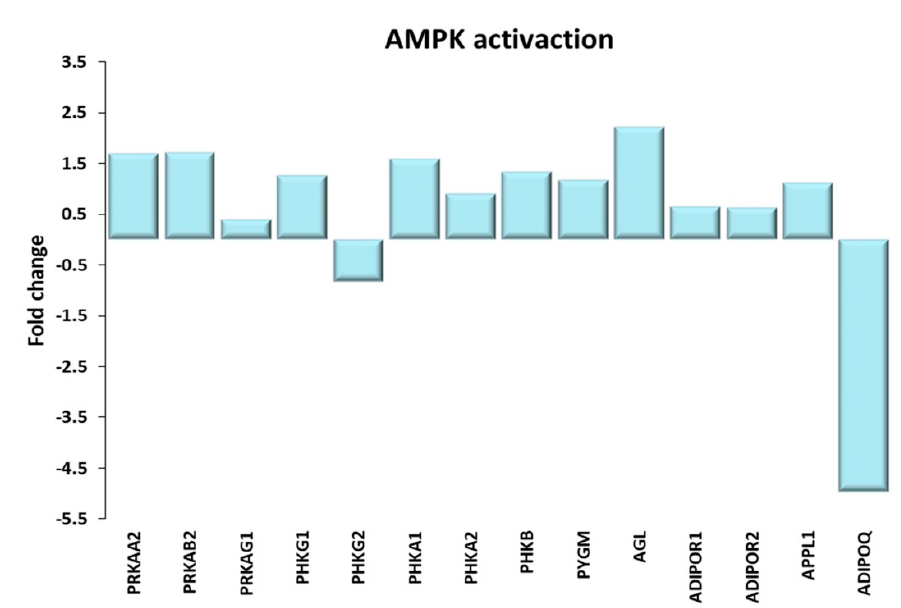
Figure 5. AMPK activation. Genes discussed in the text are shown here as fold change in the comparison of TRA and SED subjects. PRKAA2: Protein kinase AMP-activated catalytic subunit α 2; PRKAB2, PRKAG1: Protein kinase AMP-activated non-catalytic subunit β 2, γ 1; PHKG1, PHKG2: phosphorylase kinase catalytic subunit γ 1, 2; PHKA1, PHKA2, PHKB: phosphorylase kinase regulatory subunit α 1, α 2, β ; PYGM, glycogen phosphorylase, muscle associated; AGL amylo- α -1, 6-glucosidase, 4- α -glucanotransferase; ADIPOR1, ADIPOR2: adiponectin receptor 1, 2; APPL1: adaptor protein, phosphotyrosine interacting with PH domain and leucine zipper 1; ADIPOQ: